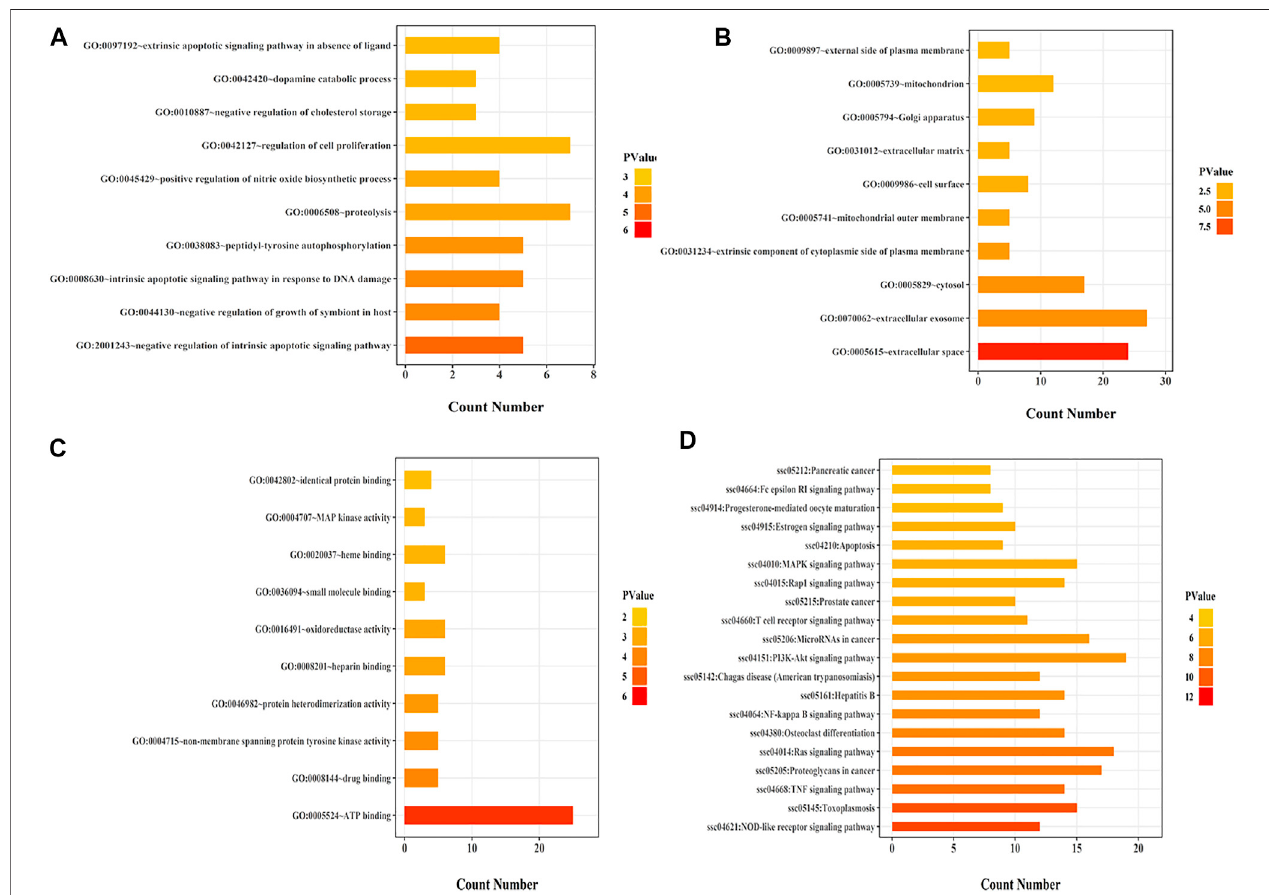
FIGURE5| TargetproteinGOenrichmentanalysisandKEGGpathwayanalysis. (A) :Thetoptensigni fi cantlyenrichedtermsinbiologicalprocess(BP); (B) :Thetop ten signi fi cantly enriched terms in cellular component (CC); (C) : The top 10 signi fi cantly enriched terms in molecular function (MF); (D) : The top 10 signi fi cantly enriched terms in